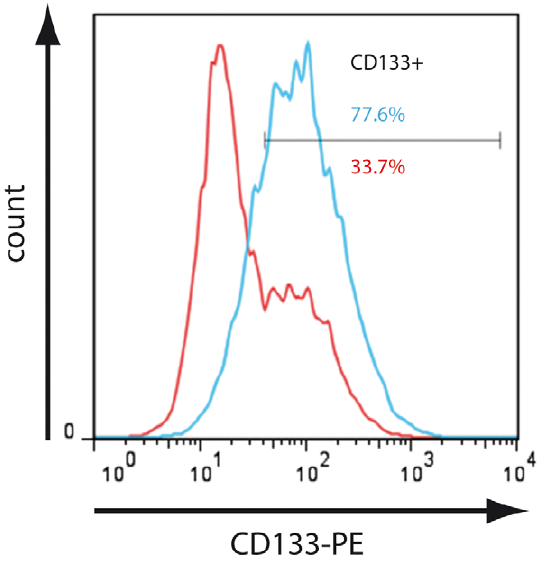
Figure 9. Enrichment of CD133 upon gemcitabine treatment. The CD133 + content of JoPaca-1 cells was determined via FACS after long-term treatment with gemcitabine (blue) and in comparison to a non-treated control (red). Prolonged gemcitabine exposure led to an increase of the CD133 + population from 33.7% to 77.6%.